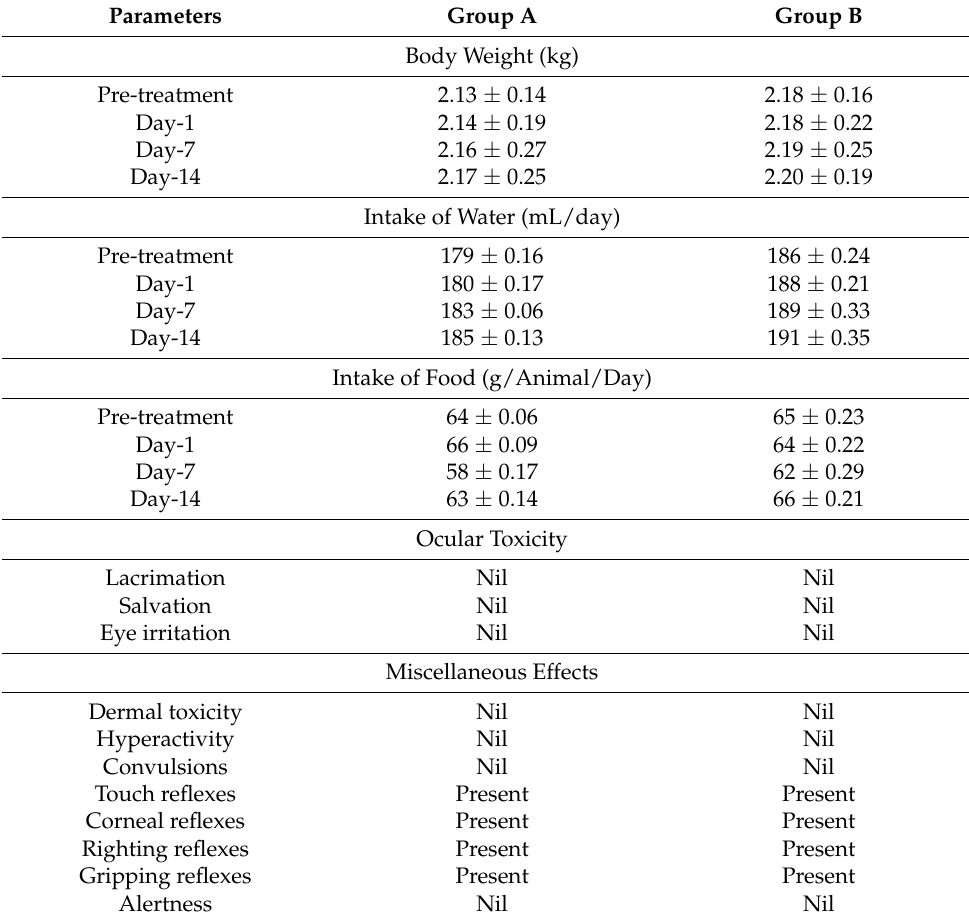
Table 7. Clinical evaluation of different parameters for acute oral toxicity of Group A and Group